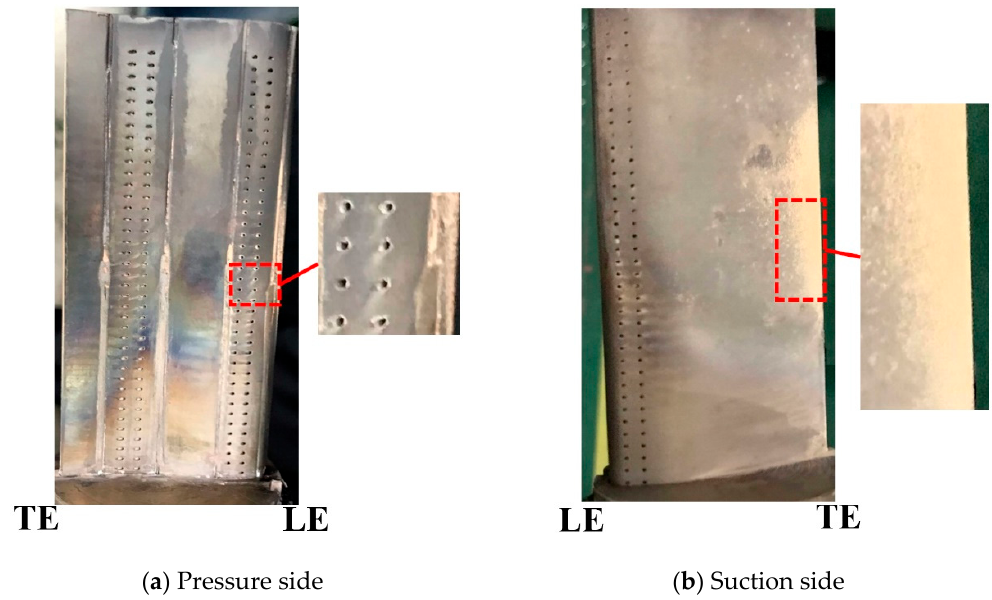
Figure 13. Photos of the sand deposition on the ( a ) pressure and ( b ) suction sides of the test model at the mainstream temperature of 1528 K. the mainstream temperature of 1528